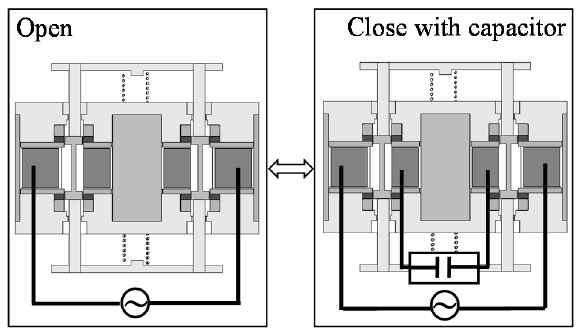
Figure 1. Basic construction of our previous actuator.